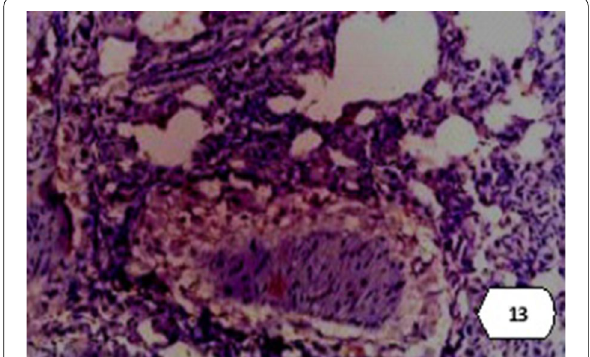
Fig. 13 Lung tissue image of Ch-NPs animals showing moderate positive COX-2 immunoreactivity around lung capillaries, bronchioles, and interstitial tissues ( 200 magnification) ×